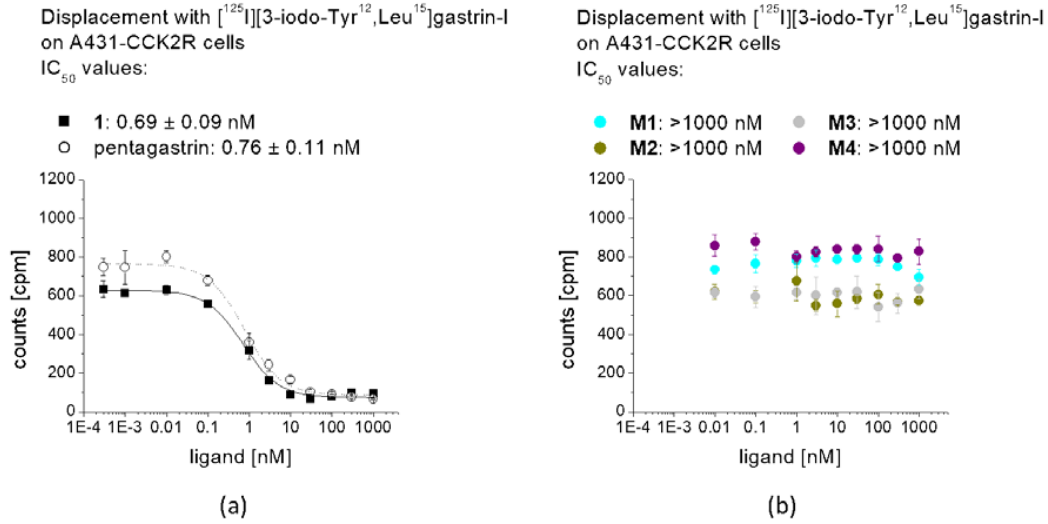
Figure 4. Cell uptake of ( a ) [ 177 Lu]Lu- 1 in A431-CCK2R and A431-mock cells and ( b ) 177 Lu-labeled